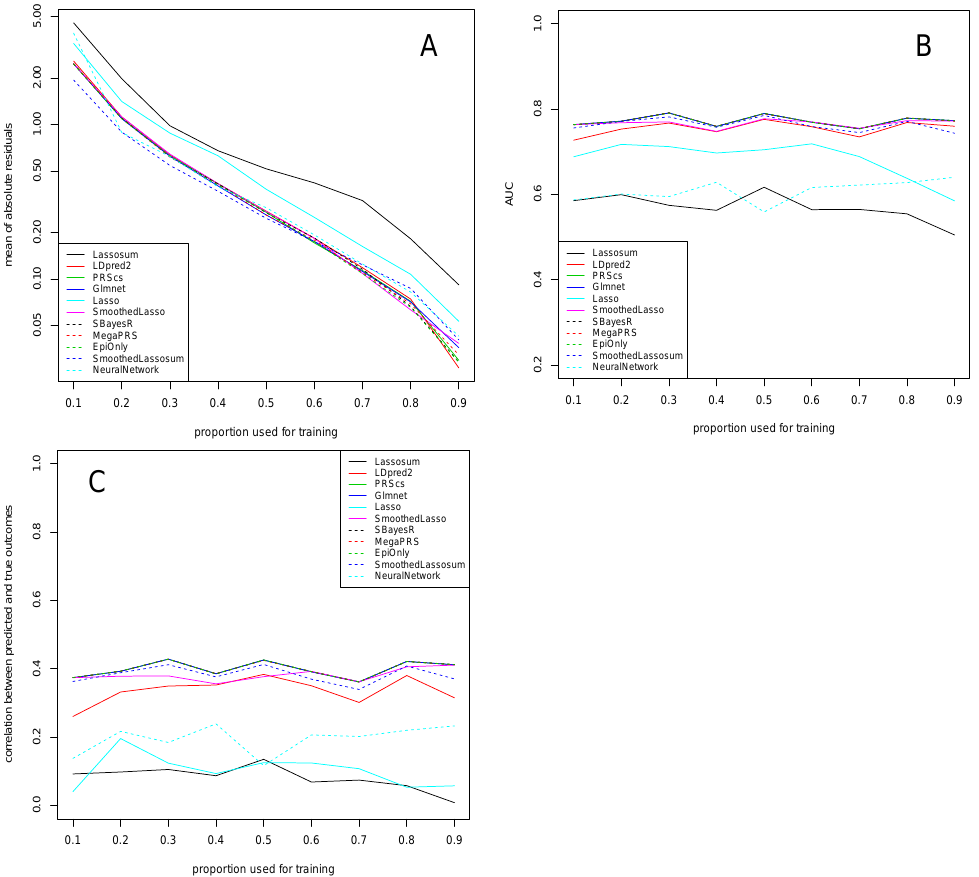
Figure 1. Dataset of clinically defined AD cases of [13]. Mean of absolute residuals ( A ), AUC ( B ), and correlation between predicted and true outcomes ( C ) as a function of the proportion of data used for training. Plotted with